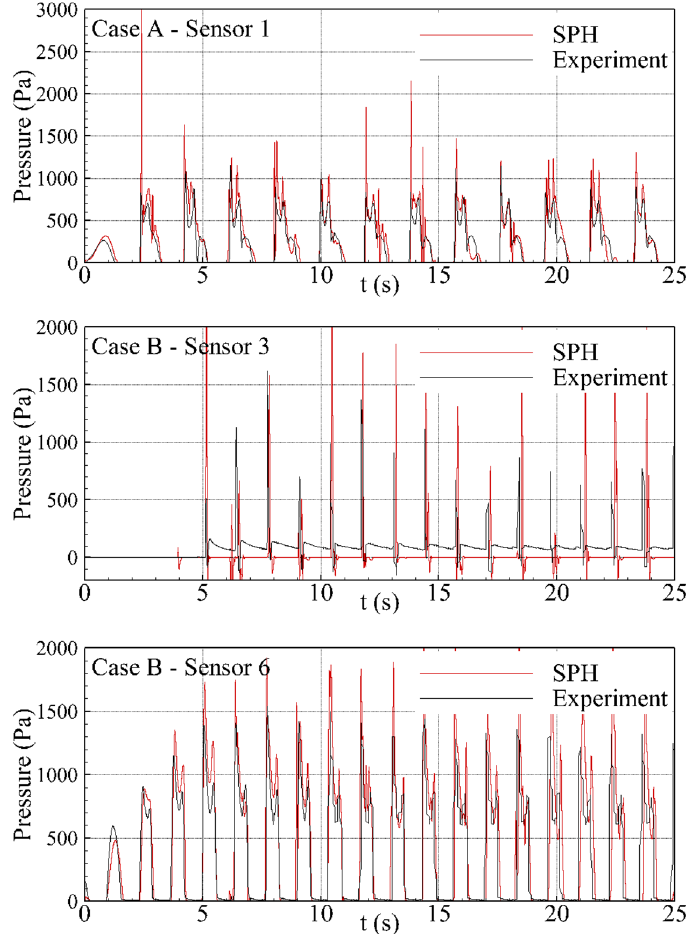
Figure 4. Comparisons of SPH − computed pressure time series at sensor points with experimental data for cases A and B.